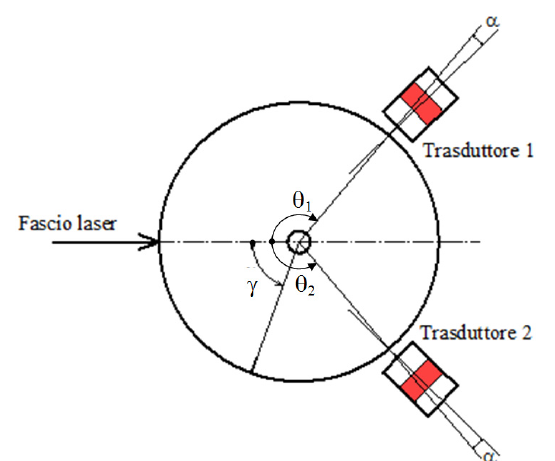
Figura 1: Configurazione per il rilievo di difetti superficiali con onda che si propaga in direzione circonferenziale. Figure 1: Setup to detect surface defects using the wave propagating along the circumferential